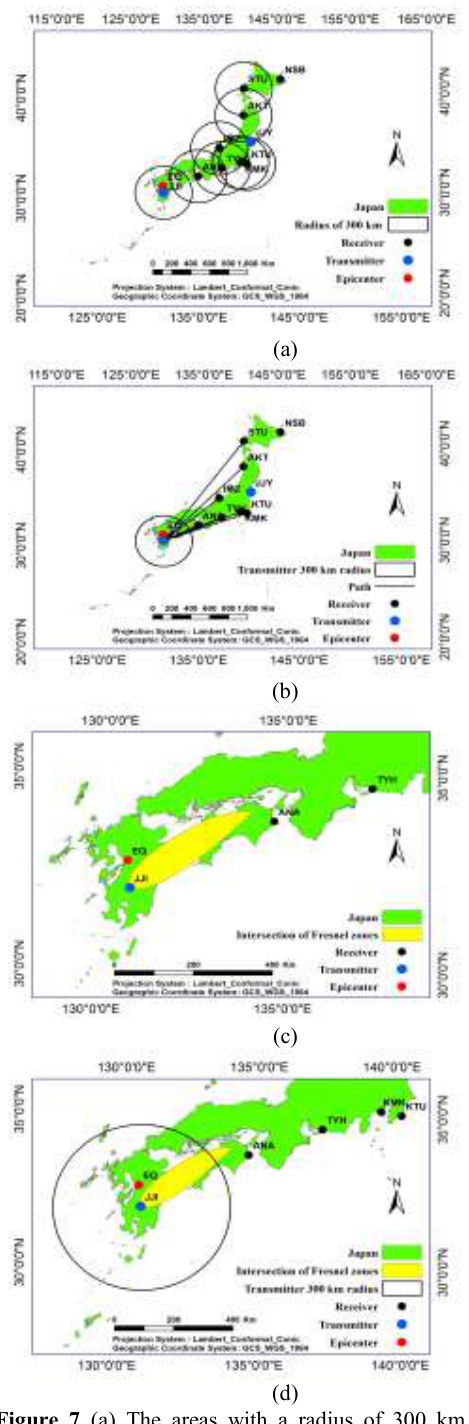
Figure 7 (a) The areas with a radius of 300 km around the transmitter and receivers (b) The intersection of the areas with a radius of 300 km for the receivers and transmitter (c) The intersection of the fifth Fresnel zones (d) The union of intersection of the fifth Fresnel zones and a radius of 300 km around the transmitter that is the location of the epicenter of the